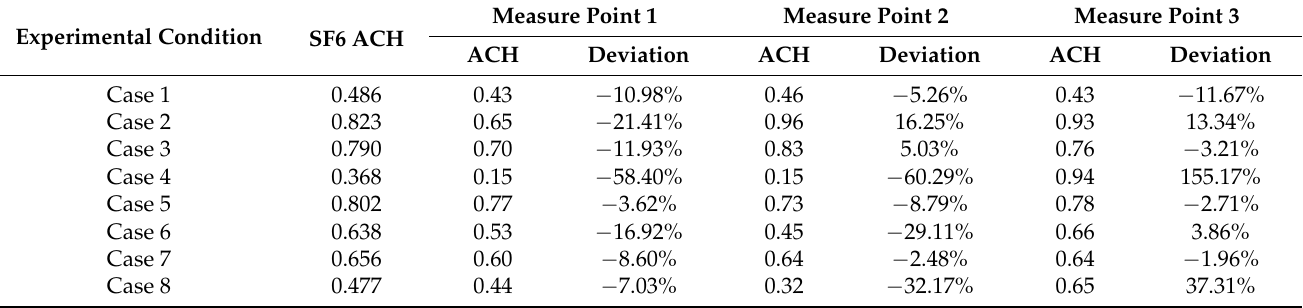
Table 8. AER calculation results using a single measurement point in the ASHRAE modified